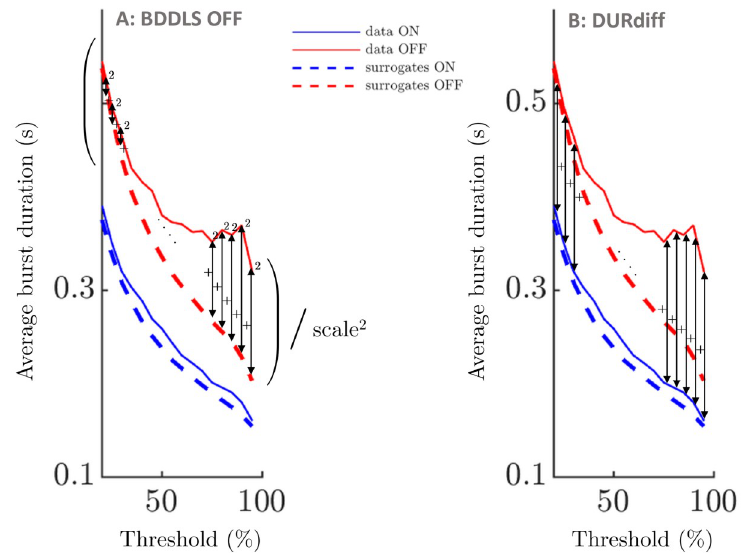
Fig 5. Sketch of burst duration metrics. A: illustration of burst duration distance to linear surrogates in the OFF state (BDDLS OFF). BDDLS OFF is defined as the sum of squared differences between data and linear surrogate average burst duration profiles for the OFF condition divided by the square of a scale. The scale is taken as the mean value of the OFF linear surrogate average burst duration profile. BDDLS ON is defined in a similar way, and BDDLSdiff is BDDLS OFF medication minus BDDLS ON medication. B: DURdiff is defined as the sum of the differences across thresholds between burst duration profiles OFF and ON medication. In this figure, summation is indicated by the symbol +, division by the symbol /, and squaring by the symbol 2 .